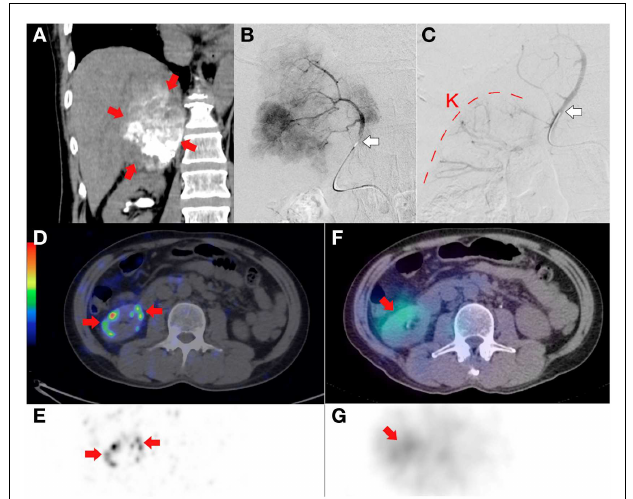
FIGURE 9 |Three examples to highlight the importance of deliberately increasing the background noise for non-target activity detection . (A,D,G) These are duplicates of Figures 2D , 7B , and 8E , which show non-target activity in the lower anterior gastric wall, right lower anterior chest wall, and right renal cortex respectively, depicted with background noise deliberately increased. (B,E,H) If the PET visual display threshold had remained at the settings used for target activity assessment, the non-target activity will appear subtle on PET and undetectable on PET/CT (C,F) . (I) Right renal cortex non-target activity is barely detectable on